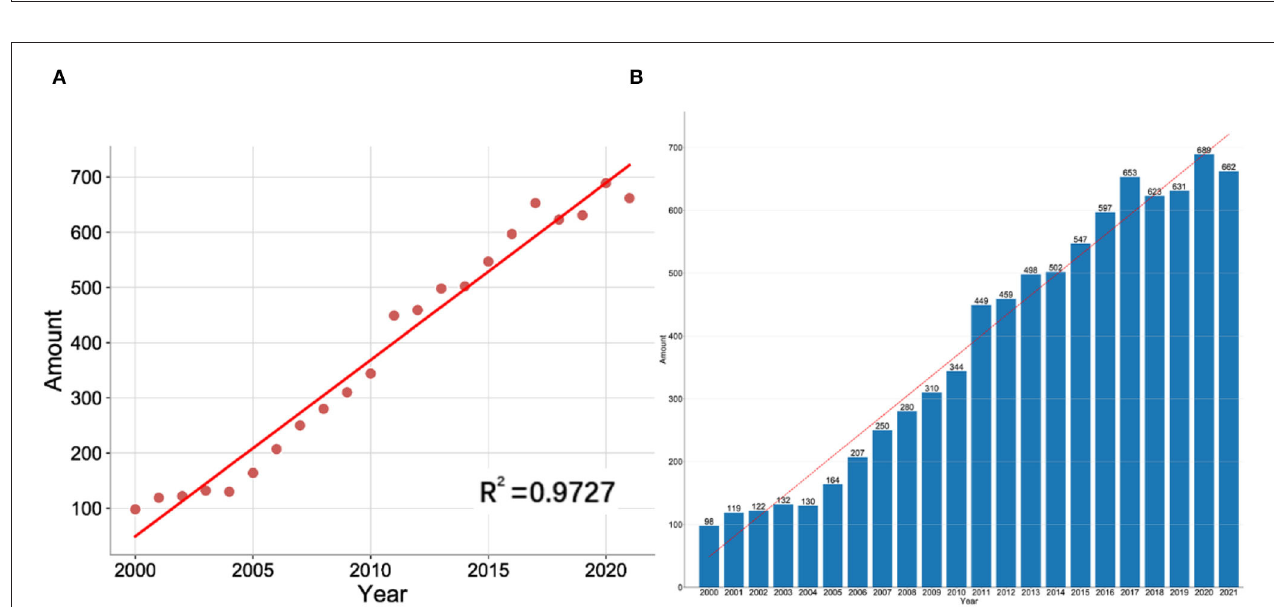
FIGURE 2 | (A) Curve fitting of the total annual growth trend of publications ( R 2 = 0.9727). (B) The number of publications by year over the past 22 years.